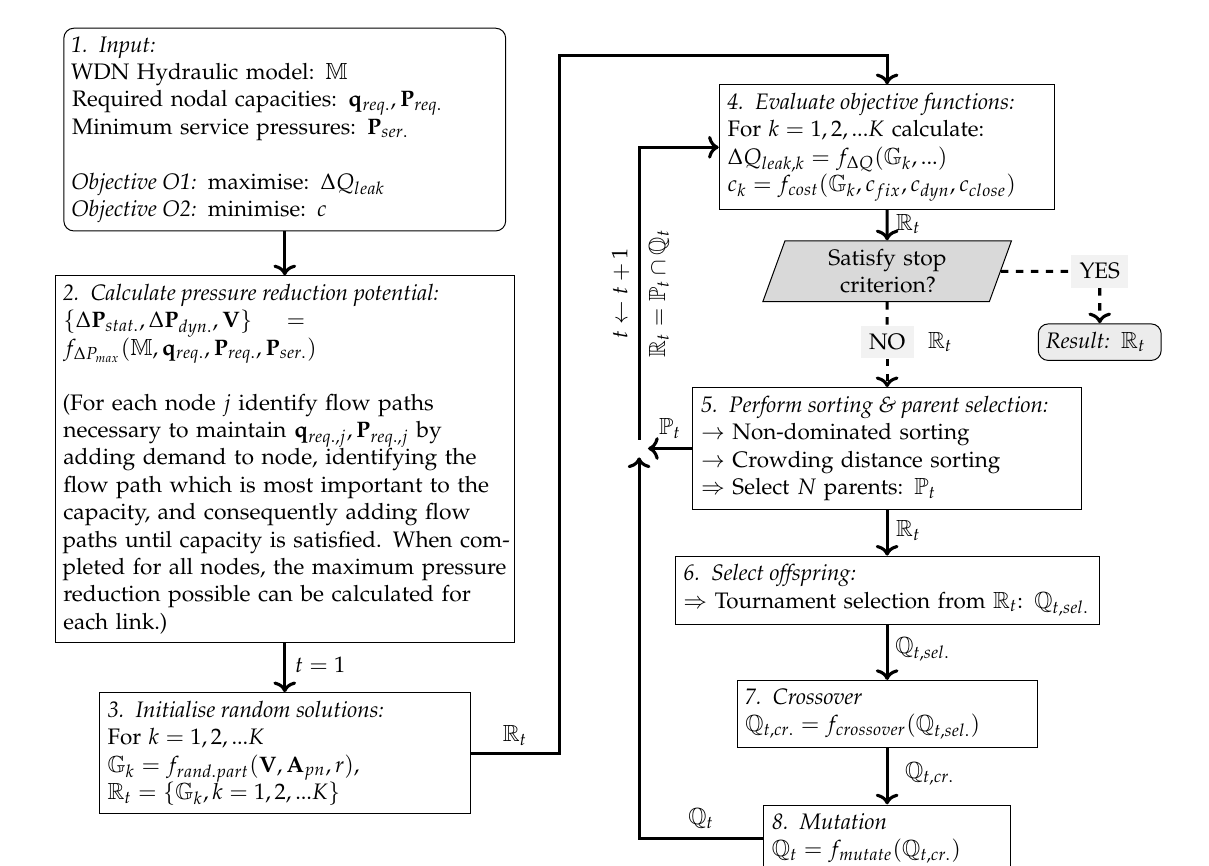
Figure 1. Flow chart with suggested